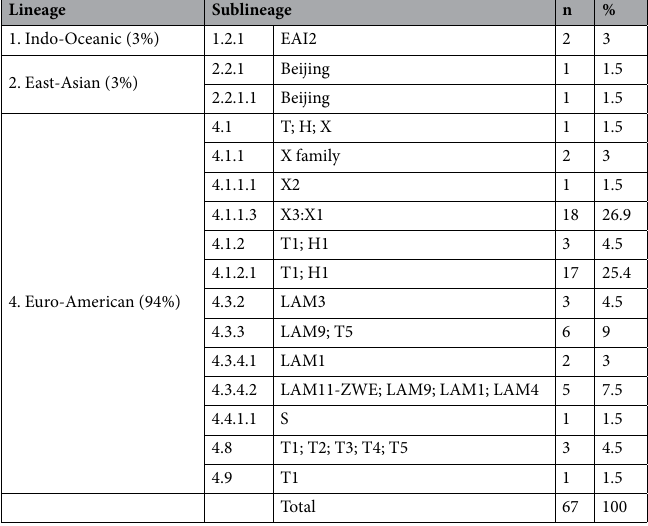
Table 1. Linages and sublineages found in isolates of drug resistant TB from Veracruz,